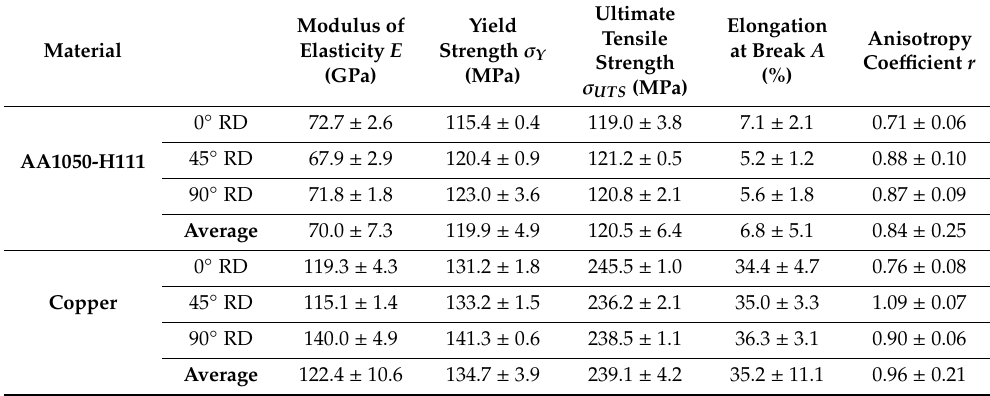
Table 3. Mechanical properties of the aluminium AA1050-H111 and copper